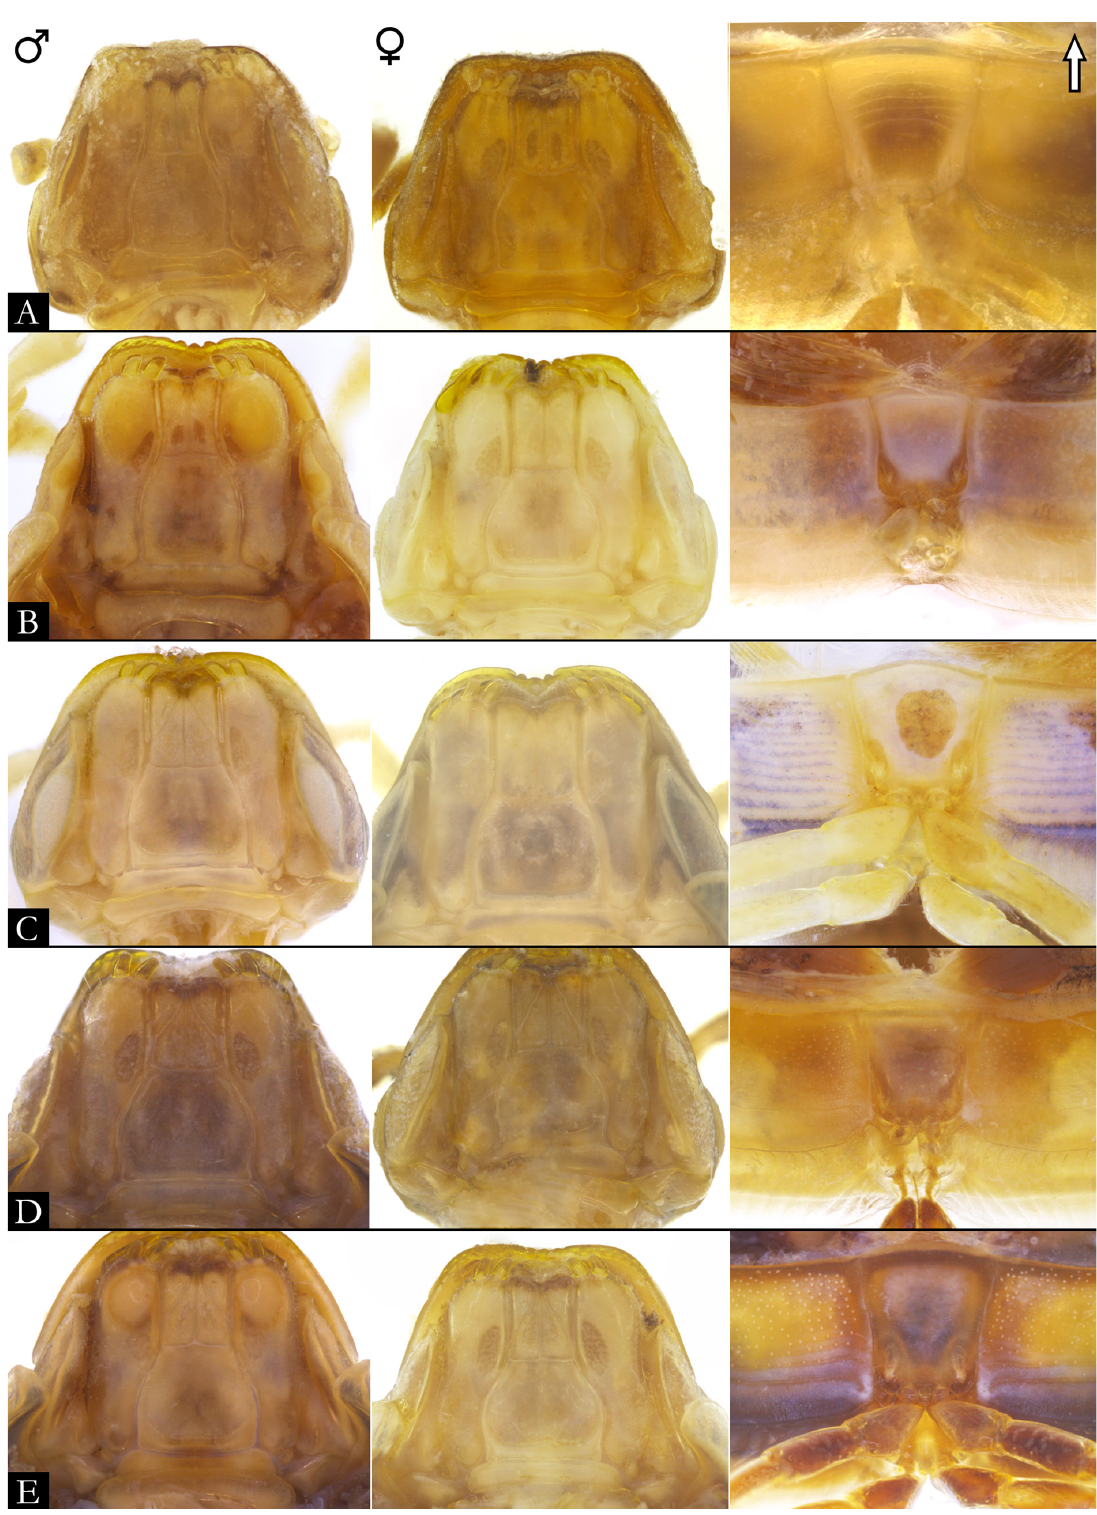
Fig. 167. Stereoscopic images of gnathochilarium and anterior sternum of species of